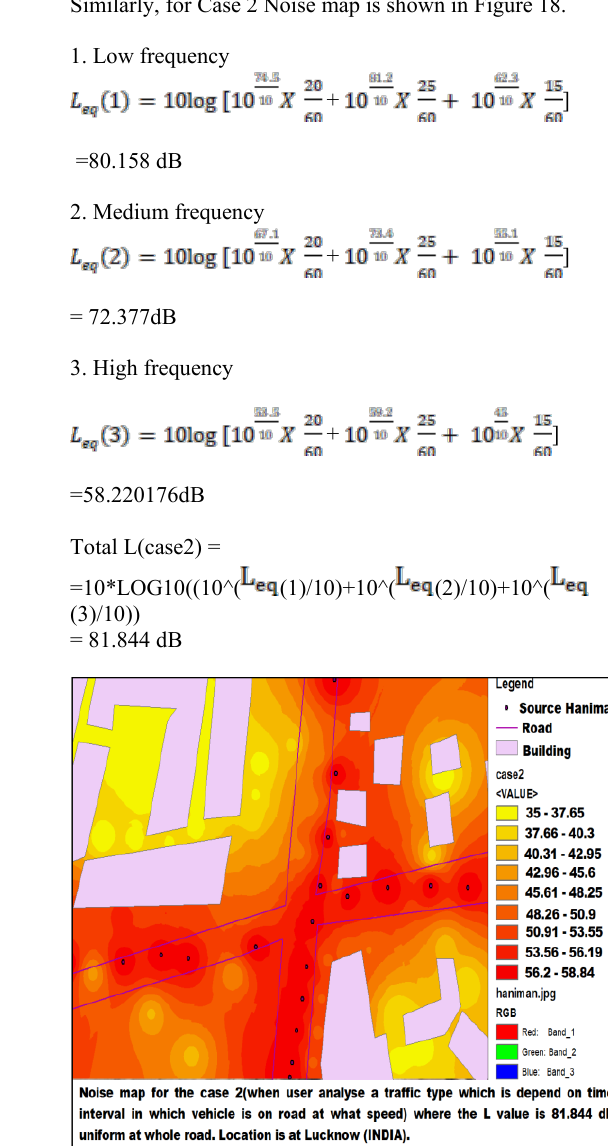
Figure 17. Noise strength for case 2